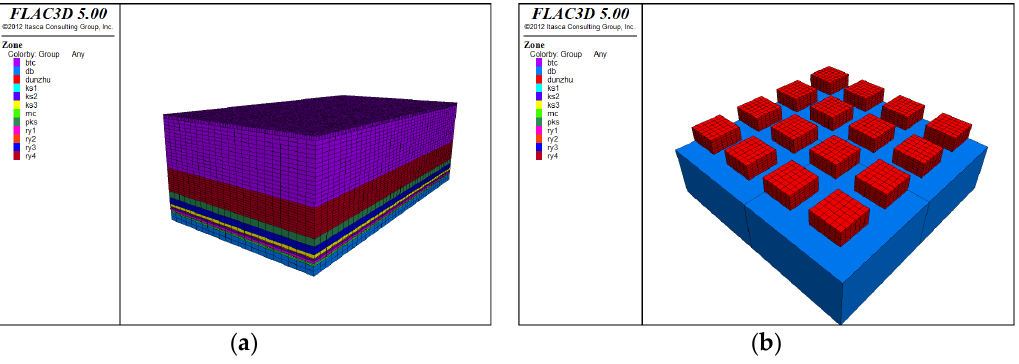
Figure 3. Schematic diagram of numerical model: ( a ) global model; ( b ) pier ‐ column arrangement. This model was primarily used to study the reduction effect of overburden subsidence in longwall pier-column backfilling, simplify the overlying strata and floor where necessary, and assigning rock mechanics parameters according to corresponding strata. Table 1 shows the mechanical parameters of the numerical model. Table 1. Mechanical parameters and layers in the numerical model.